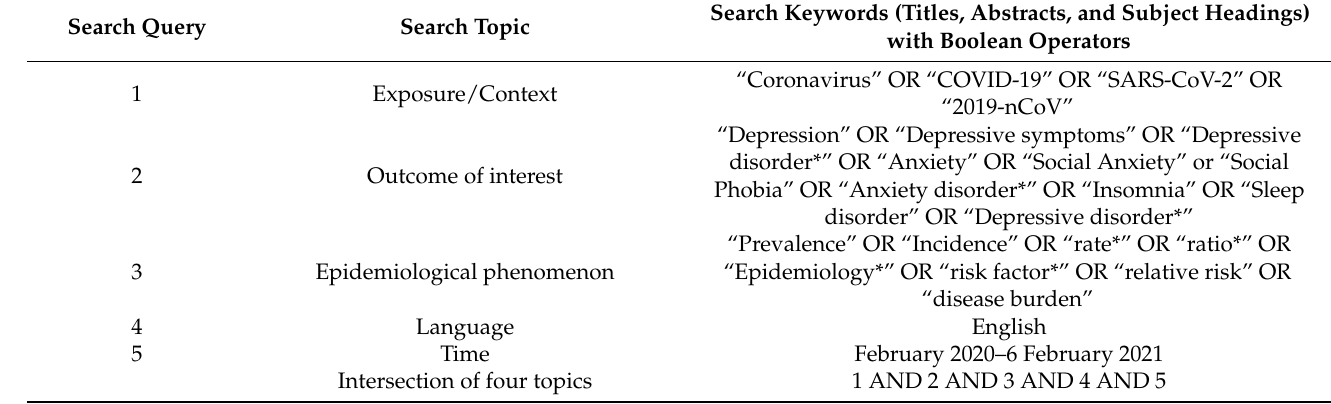
Table A1. Search strategy used in this systematic review and